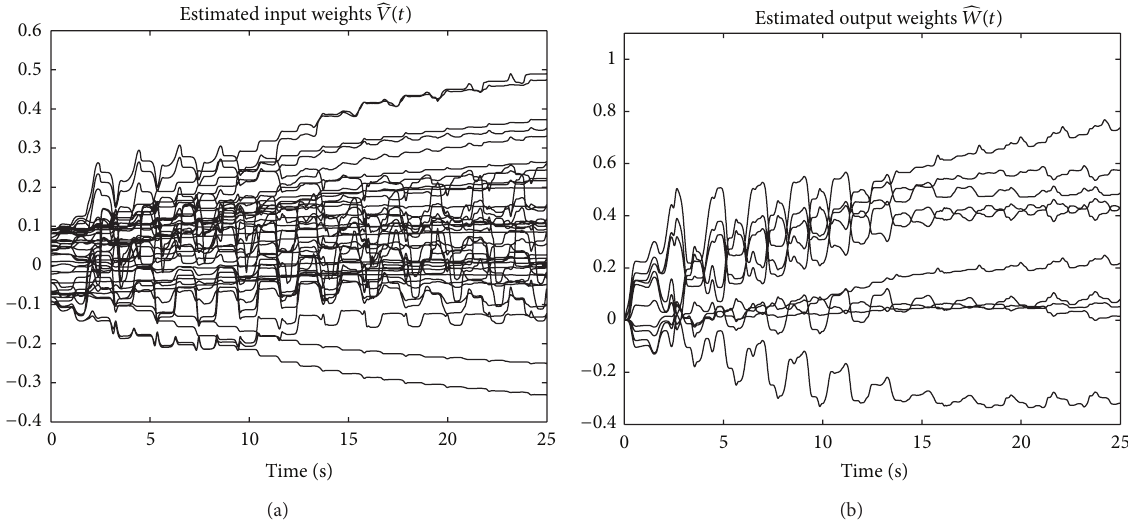
Figure 13: Experiments with the one degree-of-freedom robot: estimated input and output weights for the ANN + PD + 𝛿 sign (𝑟) controller.